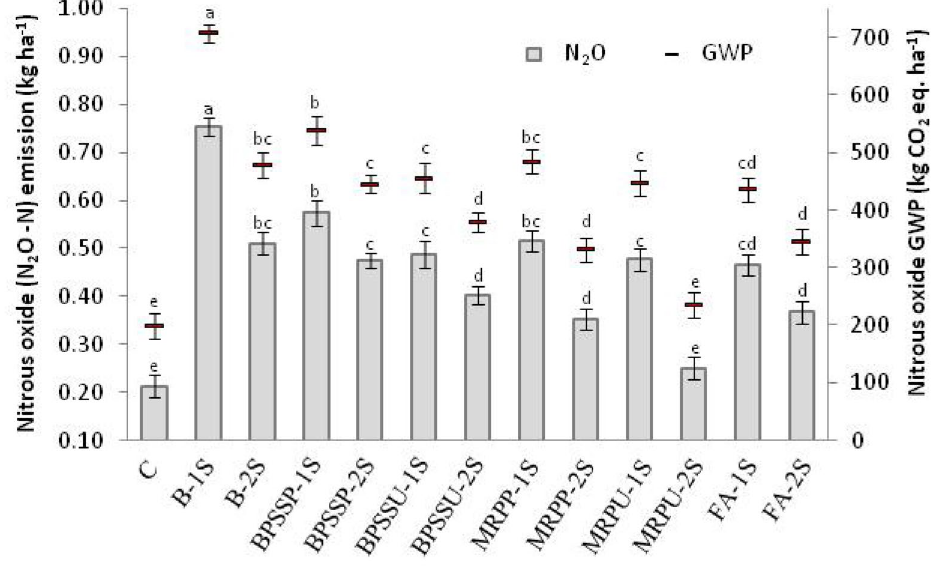
Figure 2. Nitrogen loss (as N 2 O–N) and its global warming potential as effected by various N input methods in saffron growing soils of cold humid region of North West